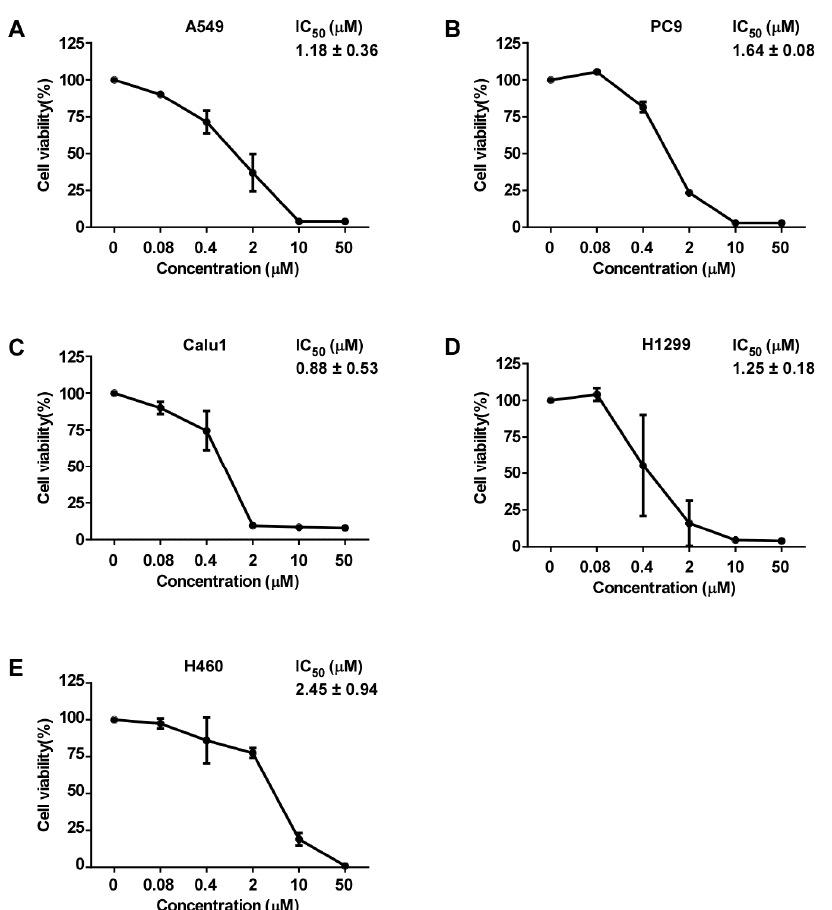
Figure 2. Growth inhibition of human lung cancer cells by D1399. Dose-response curves of D1399 against lung cancer cell lines, which included A549 ( A ), PC9 ( B ), Calu1 ( C ), H1299 ( D ), and H460 ( E ). IC 50 values of D1399 on the listed lung cancer cell lines. Cells were treated with the indicated concentrations of D1399 (0 μ M, 0.08 μ M, 0.4 μ M, 2 μ M, 10 μ M, 50 μ M) for 48 h. Cell viabilities were examined by MTT assay. Data points are shown as means ± SD of triplicate experiments.